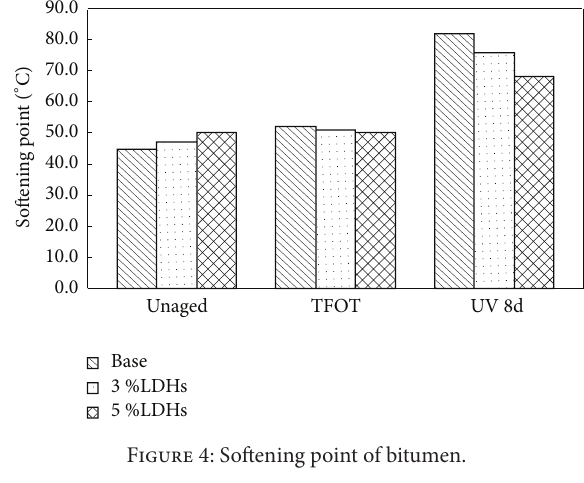
Figure 4: Softening point of bitumen.